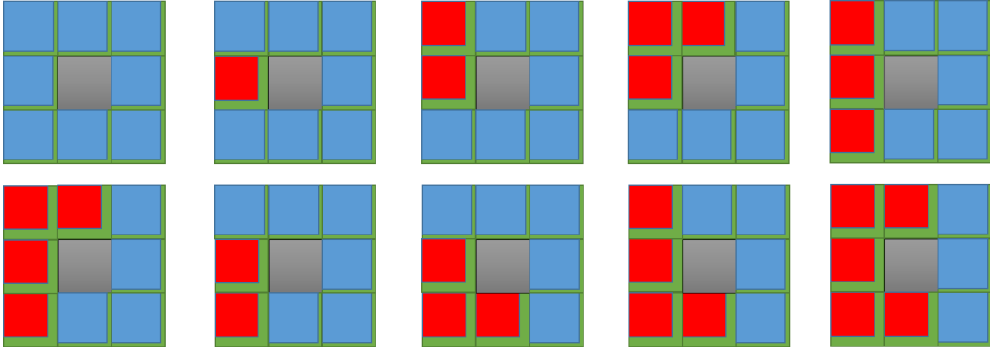
Figure 8. Map combination for the left tangent points